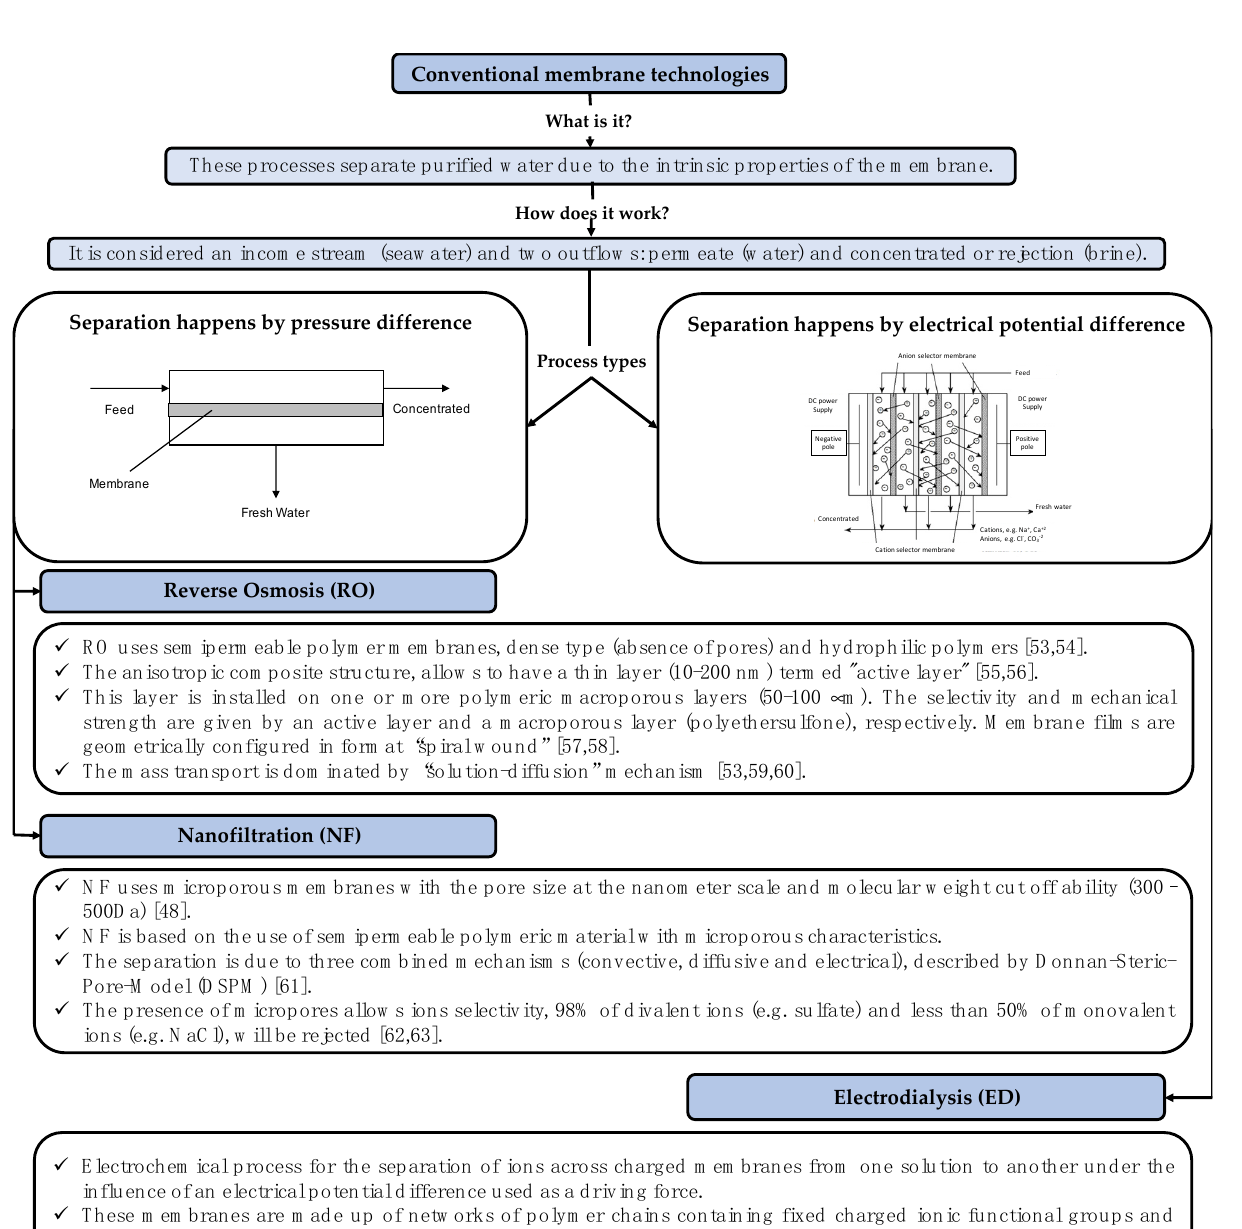
Figure 3. Conceptual diagram of the conventional membrane technologies applied to desalination (Mentioned references [53–63]).